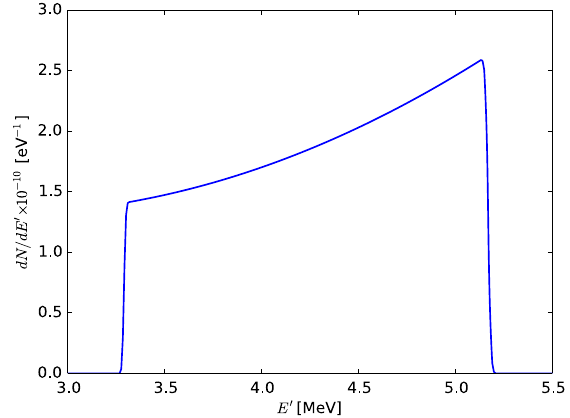
FIG. 1. The number density of the energy spectrum of a Compton gamma-ray beam produced by the head-on collision of a 466 MeV electron with a 789 nm laser beam, as in Fig. 2 in Ref. [7]. A collimation aperture with radius R of 50 mm is placed a distance L of 60 m downstream from the collision point ( θ a ¼ tan − 1 ð R=L Þ ). Here a Gaussian laser pulse with σ ¼ 50 is used, while the laser in Ref. [7] is